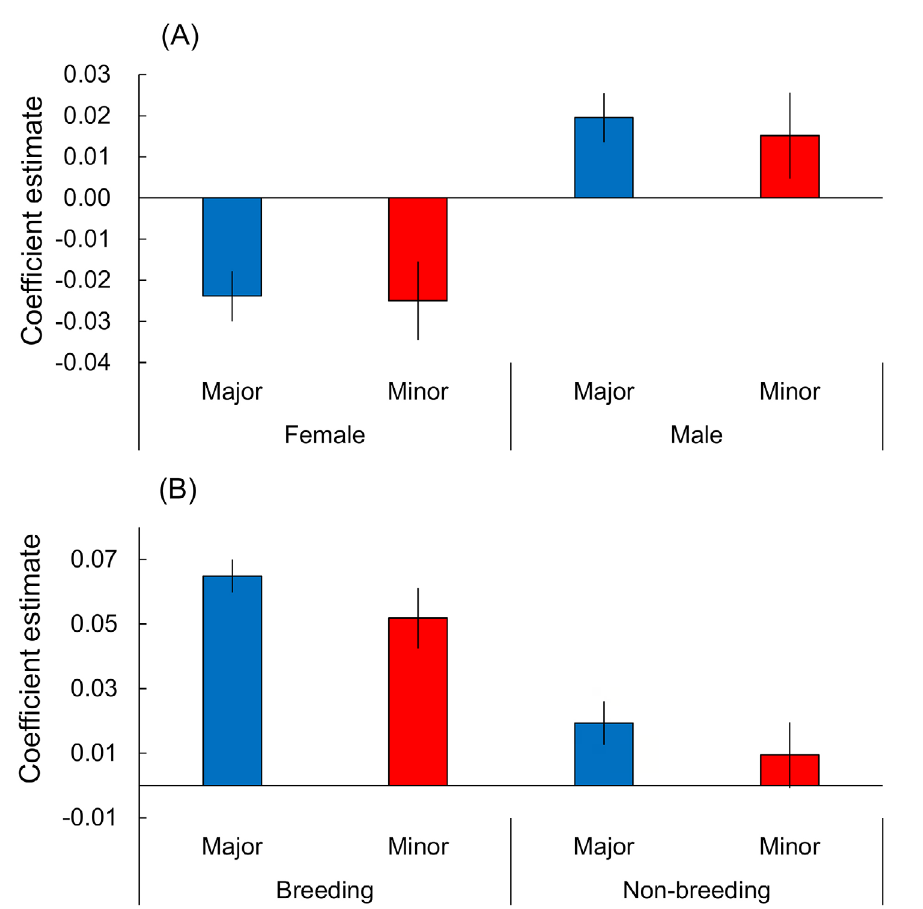
Figure 5. Intrasexual chela size dimorphism between the breeding and non-breeding seasons in each sex (A) and intersexual chela size dimorphism in breeding and non-breeding seasons (B) for major and minor chelipeds of the porcellanid crab Petrolisthes japonicus , based on the respective log-transformed allometric growth equation models between carapace width (CW) and chela size (ChS, geometric mean of the propodus length and width) of the chelipeds: lnChS = ln a + b lnCW + c lnCW × Season, where Season is the categorical explanatory variable [breeding season (May to September) or non-breeding season (October to April)] and lnChS = ln a + b lnCW + c lnCW × Sex, where Sex is the categorial explanatory variable (female or male). The coefficient estimate for each explanatory variable, including the Season or Sex, was the output for the breeding season or male, representing changes in the response variable relative to the baseline category (non-breeding season or female), and thus also representing the degree of the intra-and intersexual dimorphisms in each cheliped type. Vertical lines indicate 95 % confidence